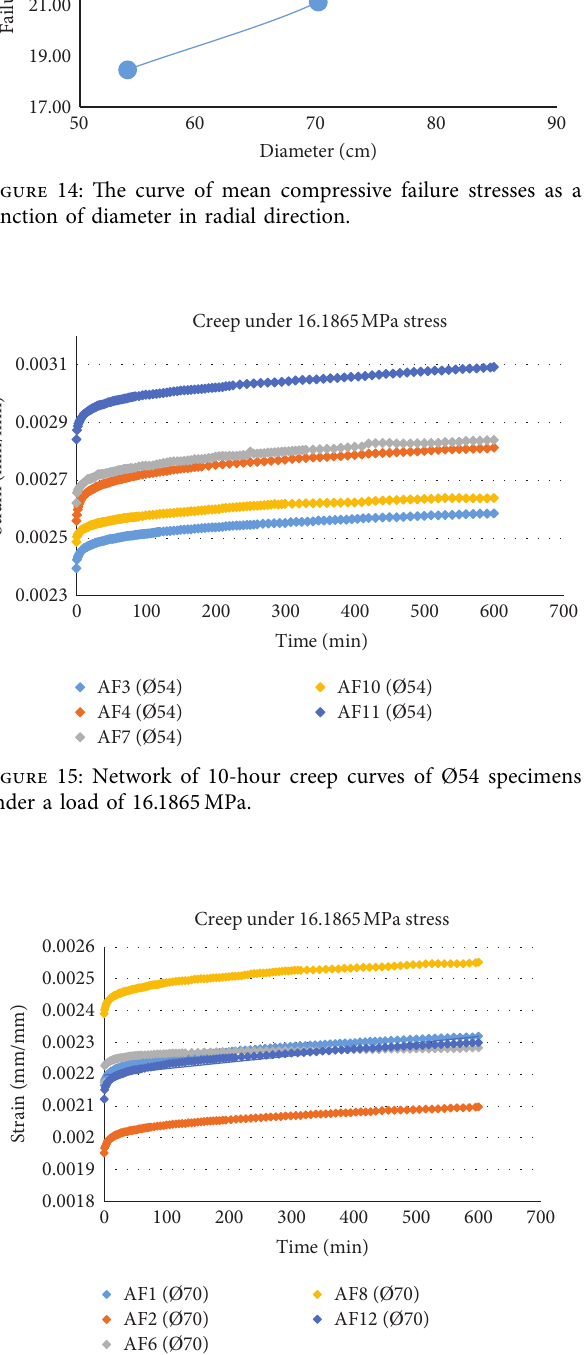
Figure 16: Network of 10-hour creep curves of Ø70 specimens under a load of 16.1865MPa.